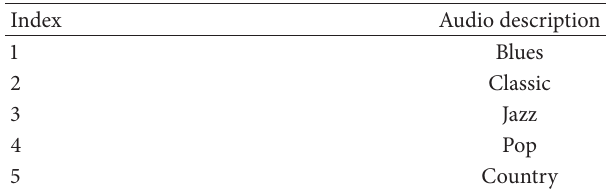
Table 1: Test database 16 bits.